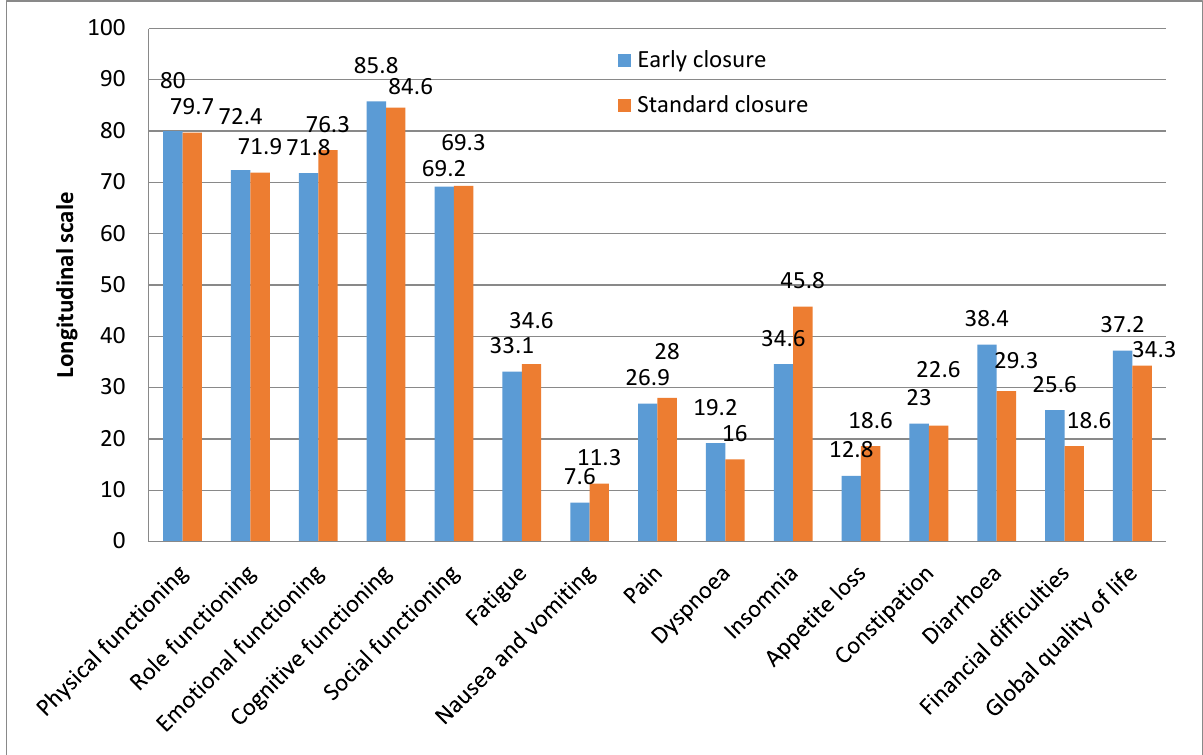
Figure 2. European Organization for Research and Treatment of Cancer Quality of Life Questionnaire Core 30 (EORTC QLQ-C30) longitudinal function, symptom and global health scales for patients undergoing early or standard ileostomy closure *. * Data were obtained from the two groups of patients: early closure group N = 26, standard closure group N = 25, using a validated questionnaire EORTC QLQ-C30. QLQ-C30 is composed of 30 items assessing global perceived health status and QoL. These items are grouped in five functional scales—physical functioning (PF), role functioning (RF), emo- tional functioning (EF), cognitive functioning (CF) and social functioning (SF); three symptom scales—fatigue (FA), nausea and vomiting (NV) and pain (PA); six single-item scales—dyspnea (DY), insomnia (SL), appetite loss (AP), constipation (CO), diarrhea (DI) and financial difficulties (FD). Scales are converted to a score ranging from 0 to 100. The higher the scores of the overall QoL and functioning scales indicate the better the overall QoL and functioning; however, the higher the scores of the symptom scales indicate the lower QoL.